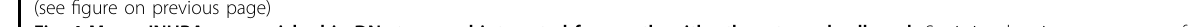
Fig. 4 Mono_INHBA was enriched in DN stage and interacted frequently with other stromal cells. a , b Statistics showing percentage of positive points for LYZ, CD14, CD4, and CD8A in whole regions (including N, DN, T, and lamina region) ( a ) and separate regions ( b ) of the fi ve representative spatial feature plots. A two-tailed paired Student ’ s t- test for the P values. * P < 0.05, ** P < 0.01, *** P < 0.001. c UMAP representation of single myeloid cells colored by subclusters. Those irregular markers represent different identi fi ed cell types. d Violin plots showing expression levels of selected in fl ammation-associated genes and monocyte markers across different myeloid cell types from scRNA-seq data. e The line charts showing changes of Mono_INHBA cell proportions in each individual from N, DN to T stages. f mIHC staining of CD68 and PD-L1 in one patient of diverse initiation stages. Scale bars: 200 μ m. Note that the statistic quanti fi cation was the average results of several representative pictures (left). The quantitation of CD68 + & PD-L1 + cell fractions in each group were provided (right). ( n = 3 groups). g Enriched M1/M2/angiogenesis/phagocytosis pathways in different myeloid cell types done with QuSAGE. h CSF1 – CSF1R interactions on Mono _ INHBA in DN stage. Signi fi cant mean and signi fi cance ( P < 0.05) were calculated based on the interaction and the normalized cell matrix achieved by Seurat Normalization. i Z-scored mean log expression heatmap of lymphatic ligands in monocytic cells (left) and receptors in T subclusters (right) from scRNA-seq data. Colored lines connect matching ligands for receptor. j Bar plots showing the signi fi cant_mean strength of representative interactions between Mono_INHBA and CAFs in N, DN, and T stages of OSCC initiation. Two-sided Wilcoxon rank-sum tests were used to calculate the statistical signi fi cance. ** P < 0.01. k Representative images of EdU and Ki67 staining in OLK organoids upon THBS1 treatment. Scale bars: 20 μ m. l Quanti fi cation of EdU (left)/Ki67(right)-positive cell proportions in OLK organoids with THBS1 treatment. Three representative pictures of each group were used for quanti fi cation. A two-tailed unpaired Student ’ s t- test for the P values. * P <